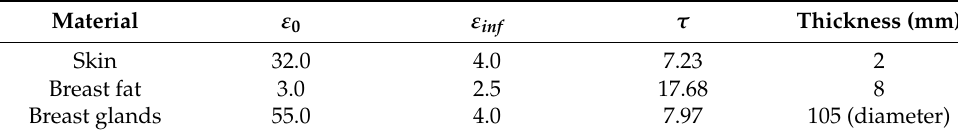
Table 4. Dielectric Properties of the Breast